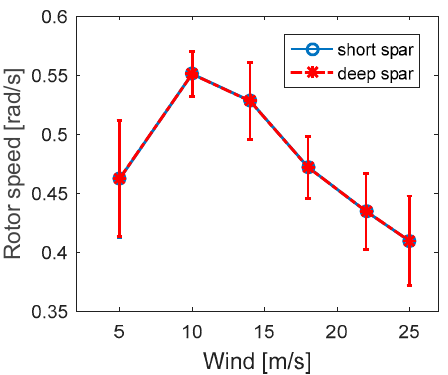
Figure 5. Mean rotor speed for the short spar VAWT and deep spar VAWT with error bar representing the standard deviation. Table 6. Mean rotor speed for all loading cases.